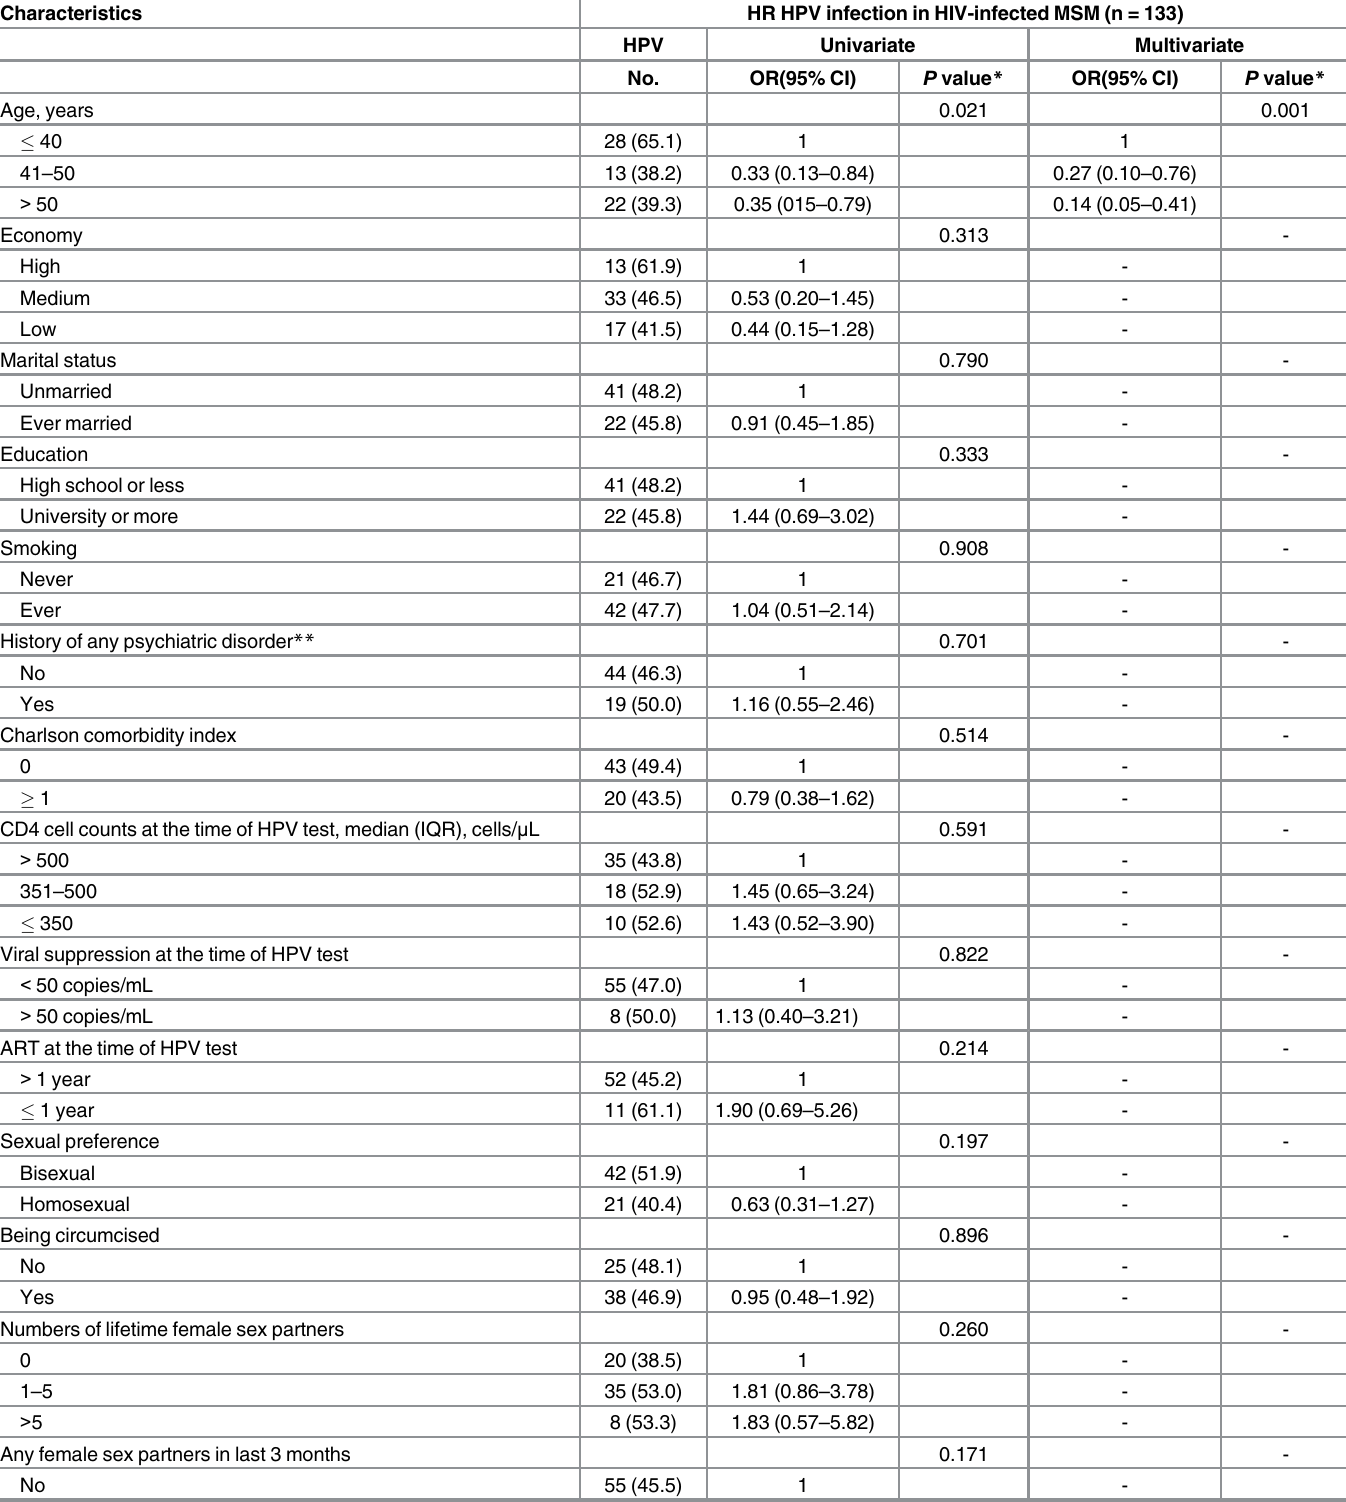
Table 4. Univariable and multivariable analyses of determinants of high risk human papillomavirus infection in HIV-infected Men who have sex with men.